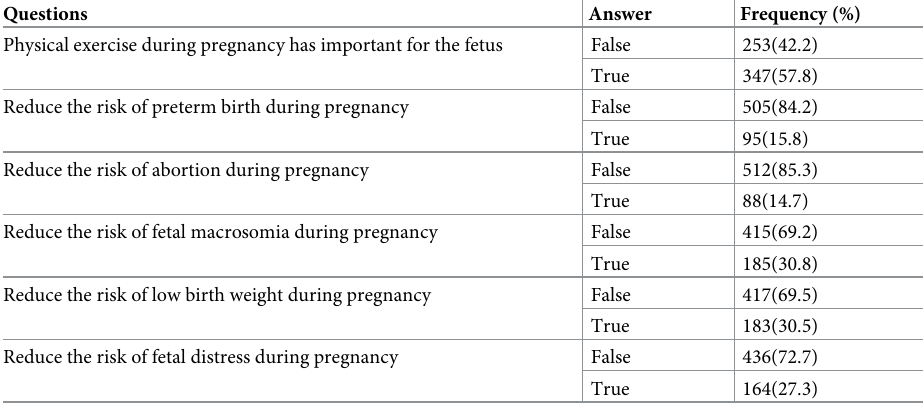
Table 6. Women’s knowledge of the benefit of antenatal physical exercise for their fetus during pregnancy among pregnant women in Hawassa city, Sidama Regional State, Ethiopia, 2021. Questions Physical exercise during pregnancy has important for the fetus